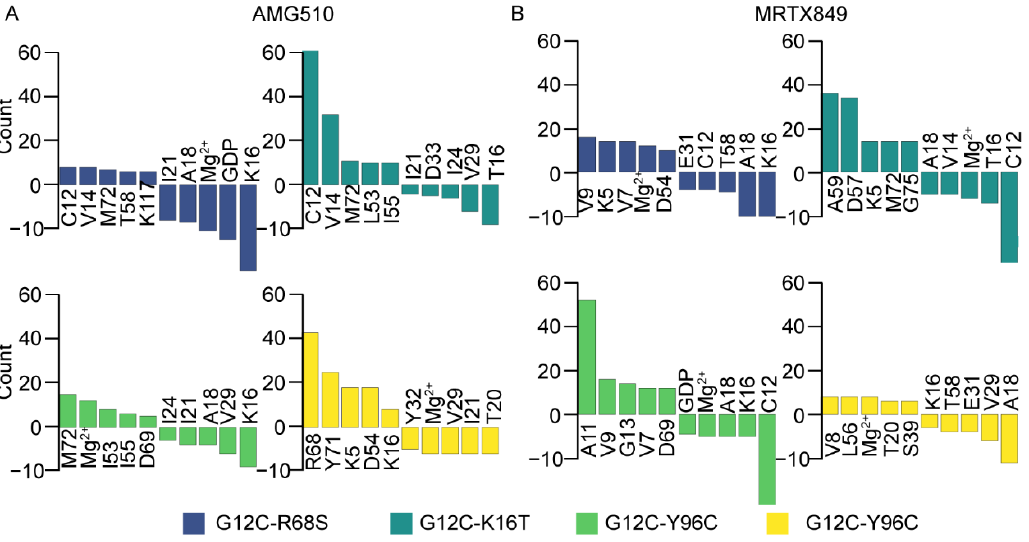
Figure 13. Allosteric signal statistical analysis forAMG510 ( A ) and MRTX-bound ( B ) complexes. A positive value indicates an increase in the number of signal pathways compared to the correspond- ing KRAS-G12C system. A negative value indicates a decrease in the number of signal pathways compared to the corresponding KRAS-G12C system. Residues located at the two switch regions and the C1′ atom on the GDP are used for allosteric connectivity analysis.